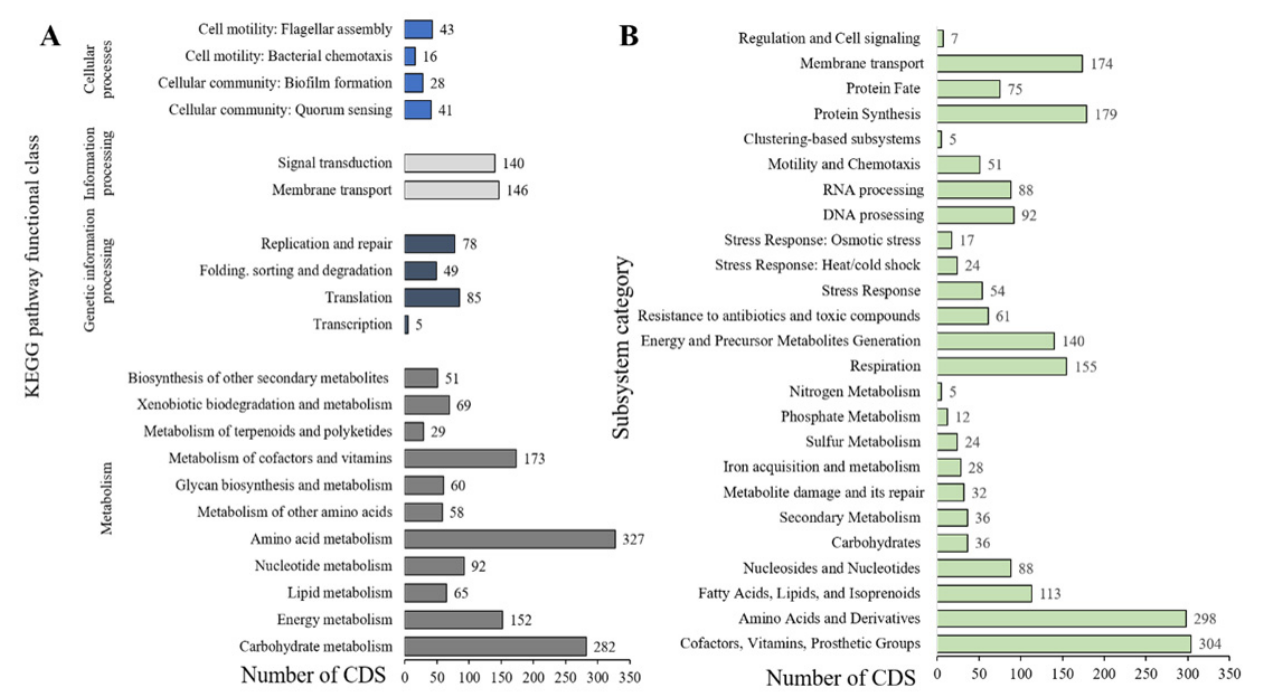
Figure 4. KEGG pathway classification of predicted genes in the ZCR6 strain using KEGG BlastKo- ala ( A ). Protein-coding sequences grouped into the functional subsystems in the ZCR6 genome us- ing RASTtk ( B